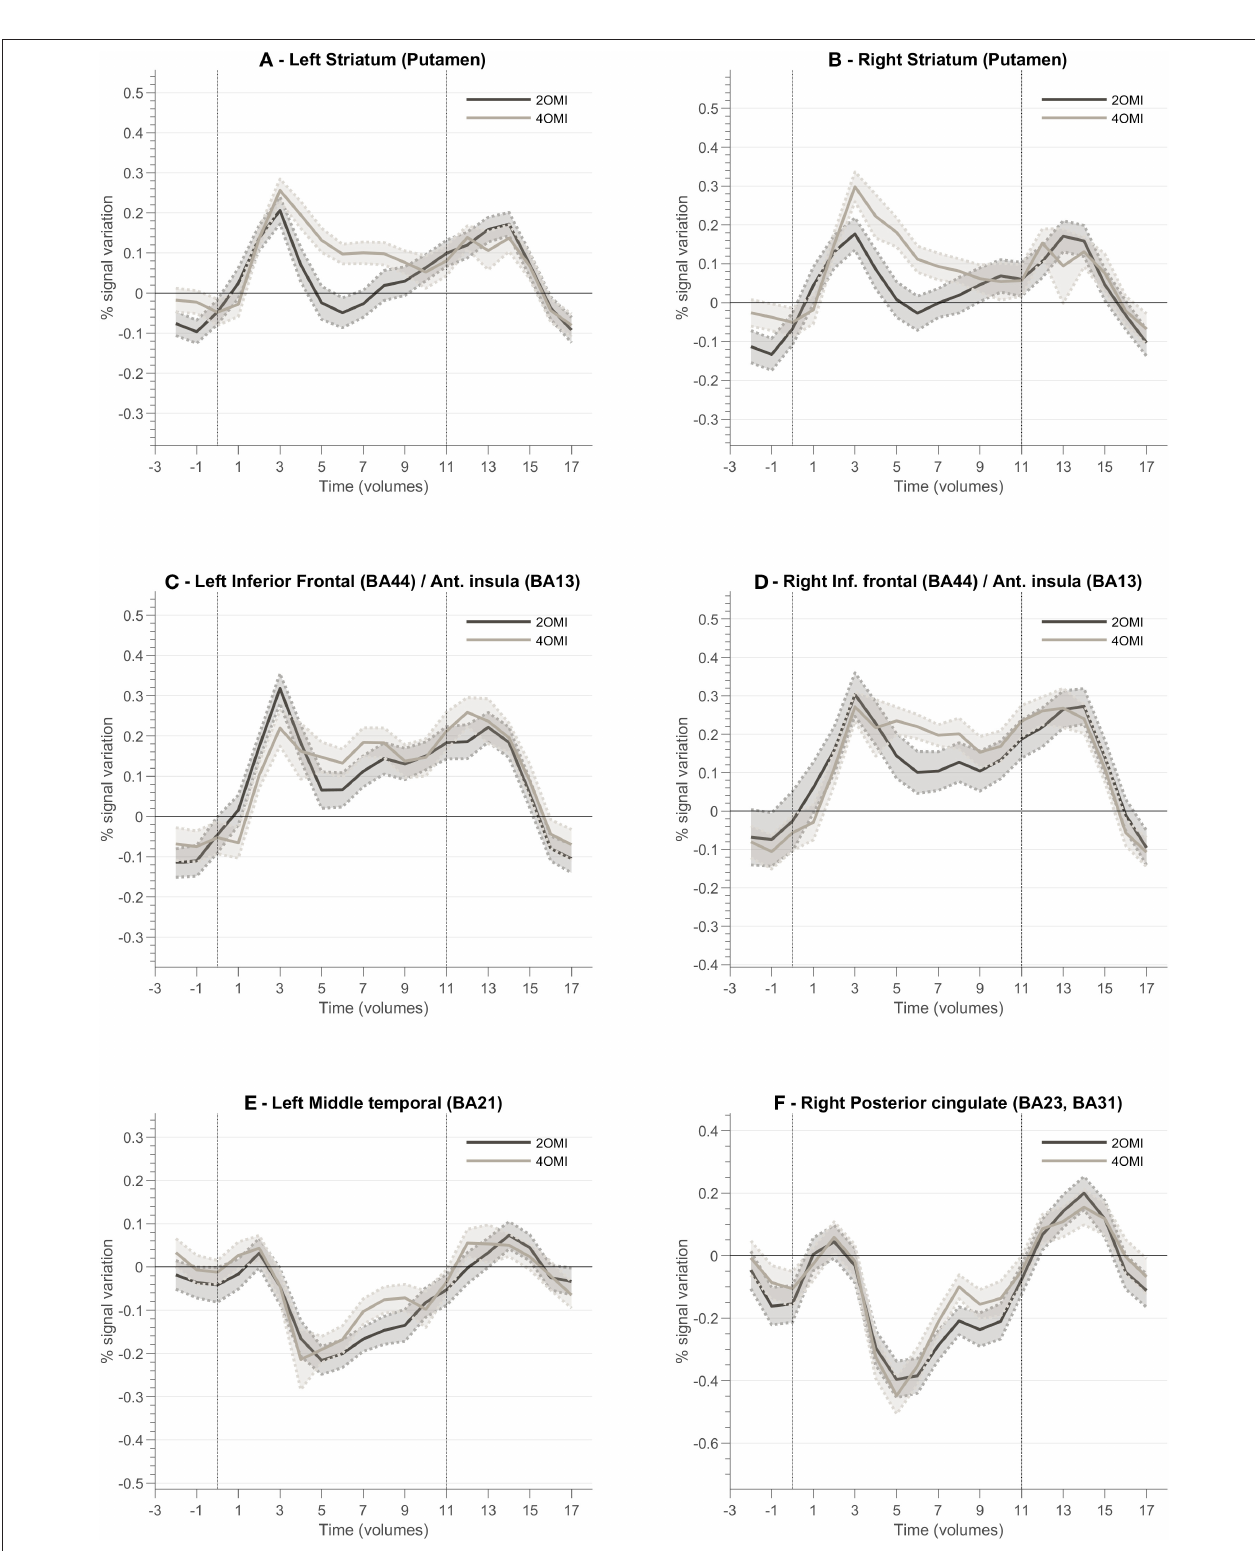
FIGURE 7 | Block-related responses averaged across all participants for different ROI involved in the neurofeedback task and identified based on ANOVA 3-level within-subject factor analysis. Each plot presents the block-related curve for the conditions 2OMI and 4OMI for the following ROIs: (A) Left Striatum (Putamen); (B) Right Striatum (Putamen); (C) Left Inferior Frontal Cortex (Brodmann Area, BA, 44)/Anterior Insula (BA13); (D) Right Inferior Frontal Cortex (BA44)/Right Anterior Insula (BA13); (E) Left Middle Temporal Cortex (BA21); (F) Right Posterior Cingulate Cortex (BA23, BA31).